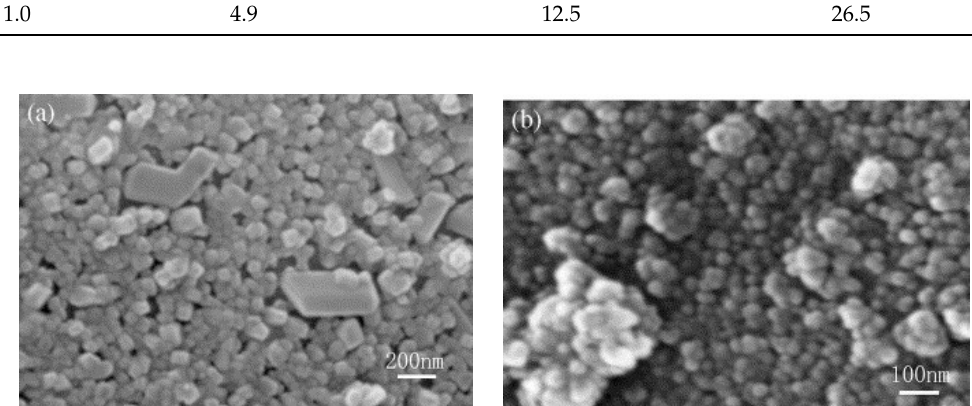
Figure 10. SEM micrographs of the morphology of the TiO 2 thin layers on mica particles ( a ) sample obtained in experiments 3, 4; ( b ) sample obtained in experiments 1, 2. Table 2. Conditions of electrodialysis and the degree of deposition of TiO 2 on the flakes.